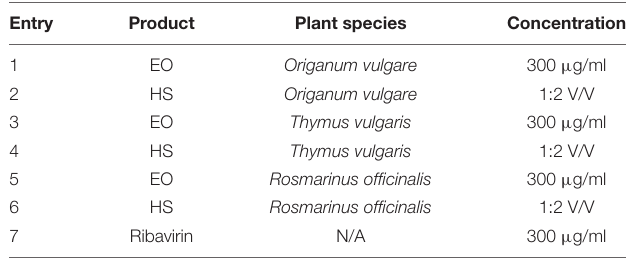
TABLE 2 | Summary of treatments applied in experimental